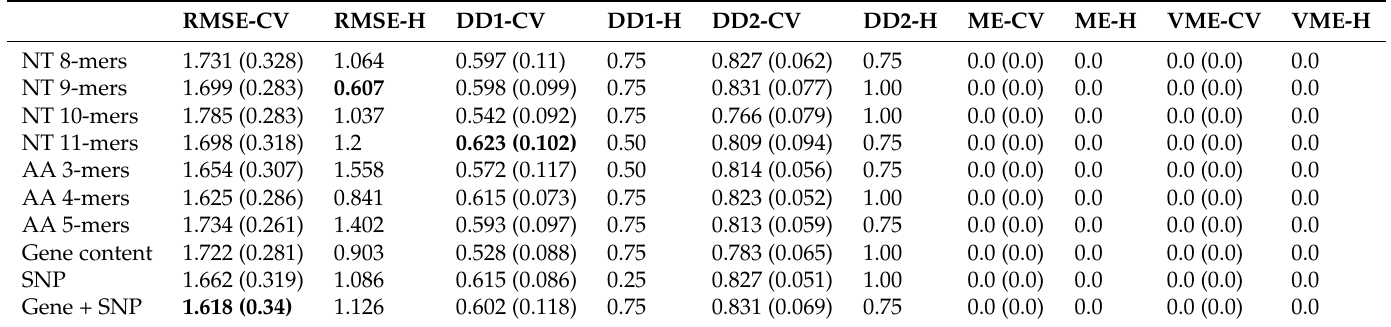
Table A24. N. gonorrhoeae